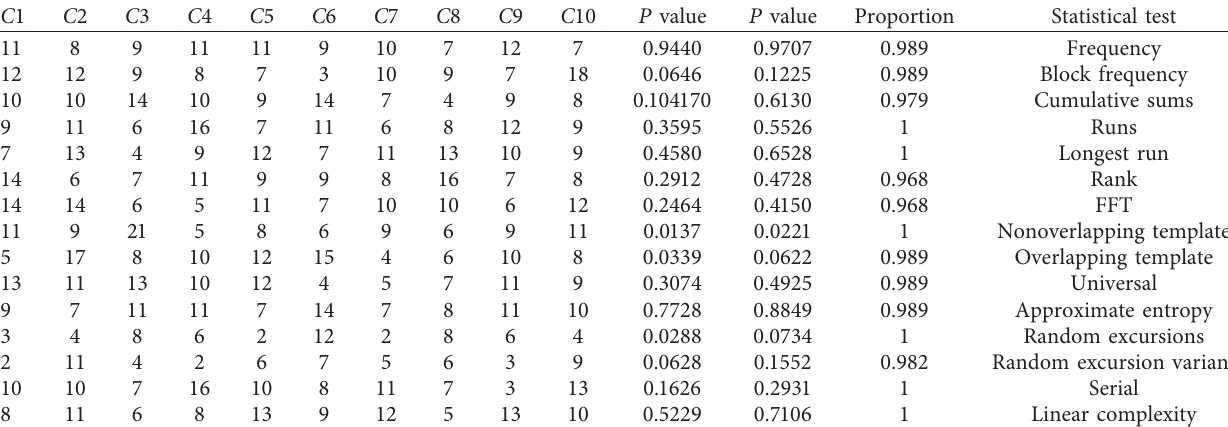
Table 2: NIST test result of Case 1 system.